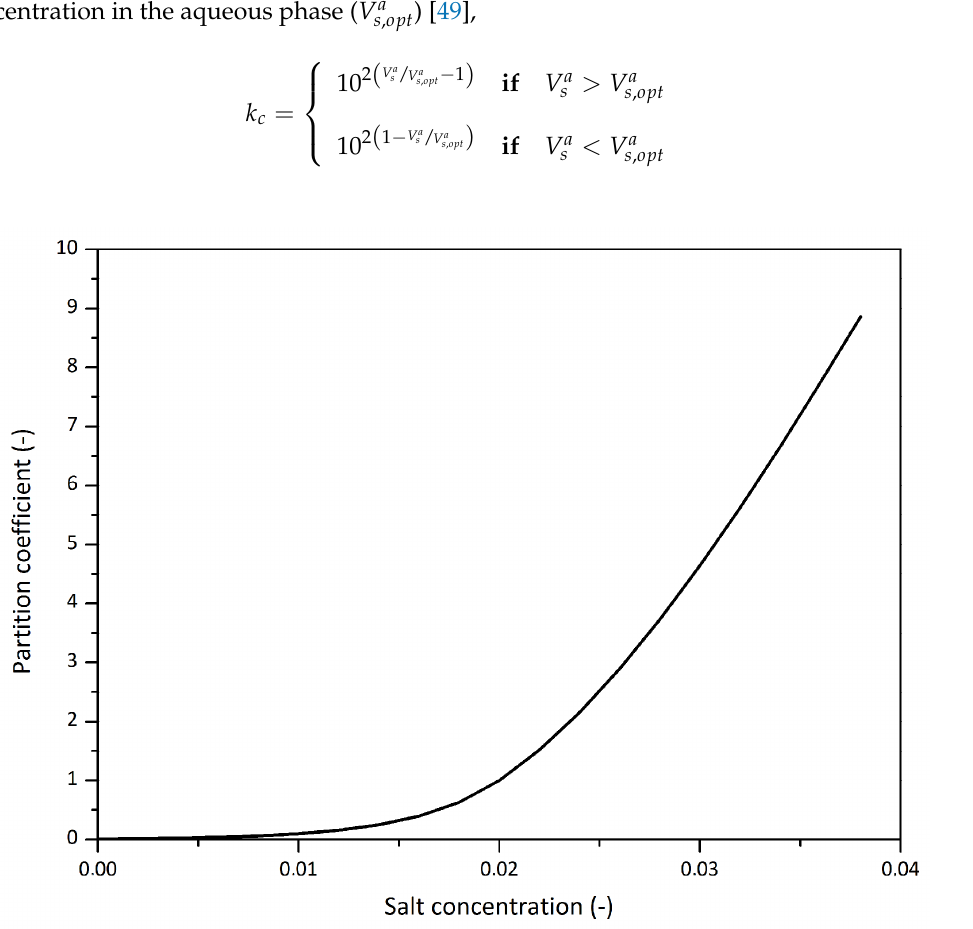
) was adopted from Sheng [51] and it is s , opt